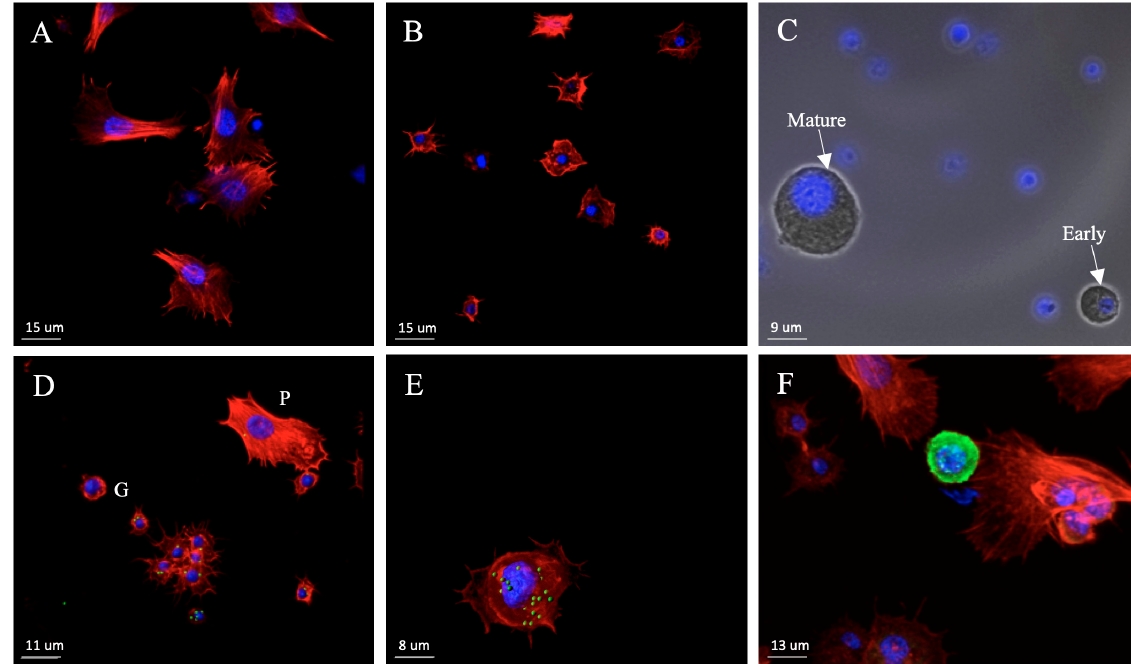
Figure 2. Morphology of the three main types of hemocytes in fifth instar P. napi larvae: ( A ) plasmatocytes, ( B ) granulocytes, and ( C ) early and mature oenocytoids. Hemocytes of P. napi larvae after in vivo phagocytosis of E. coli (AlexaFluor488, green): ( D ) plasmatocyte (indicated by P ), granulocytes (indicated by G ), ( E ) and early oenocytoid. ( F ) Staining of an oenocytoid with PPO antibody (green). Cell nuclei are stained with DAPI (blue) and the cytoskeleton of ( A , B , D – F ) with phalloidin (red). Scalebar = 15 um. Images taken using epifluorescent microscope ( C ) and confocal microscope ( A , B , D – F ).